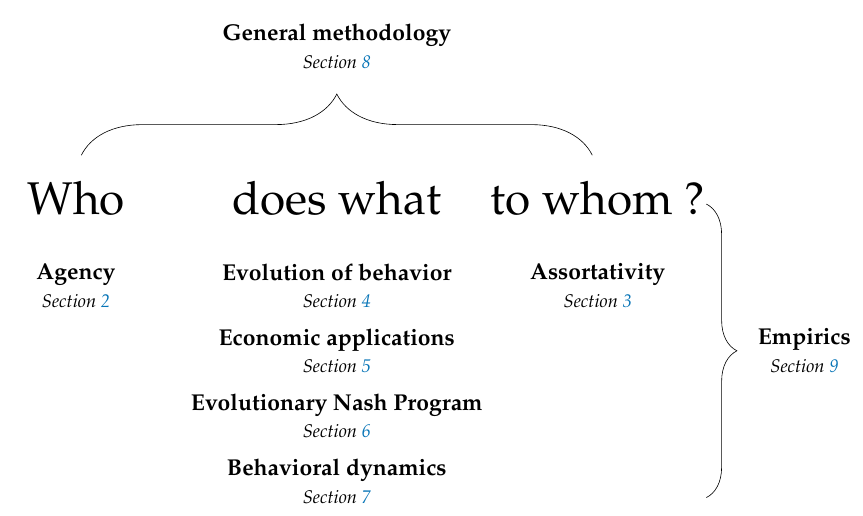
Figure 1. Structure of this survey. A model of behavior answers the question who does what to whom and in what circumstances? Explicit rules of behavior address the circumstances of every state. Equilibrium models address the circumstances of equilibrium. The remaining parts of the question are addressed by the sections of this survey as given